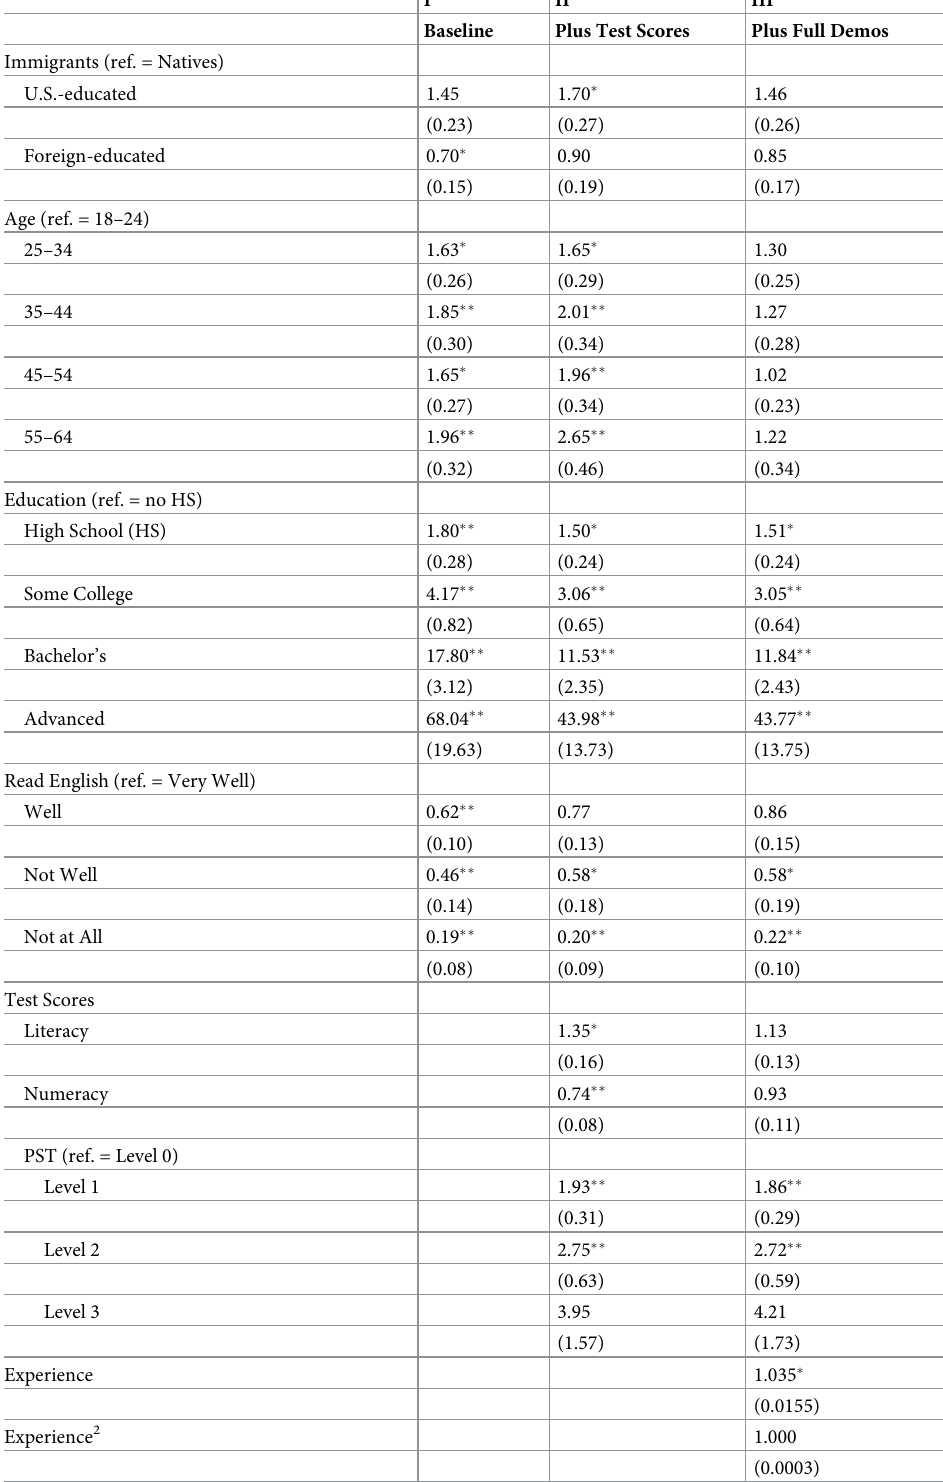
Table 7. Effect of controlling for test scores on the immigrant-native gap in occupational skill